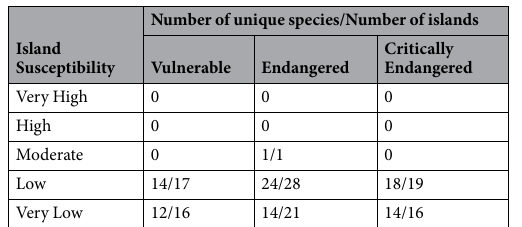
Table 3. The number of unique species (found on one island susceptibility class only) and the number of islands in that susceptibility class hosting the